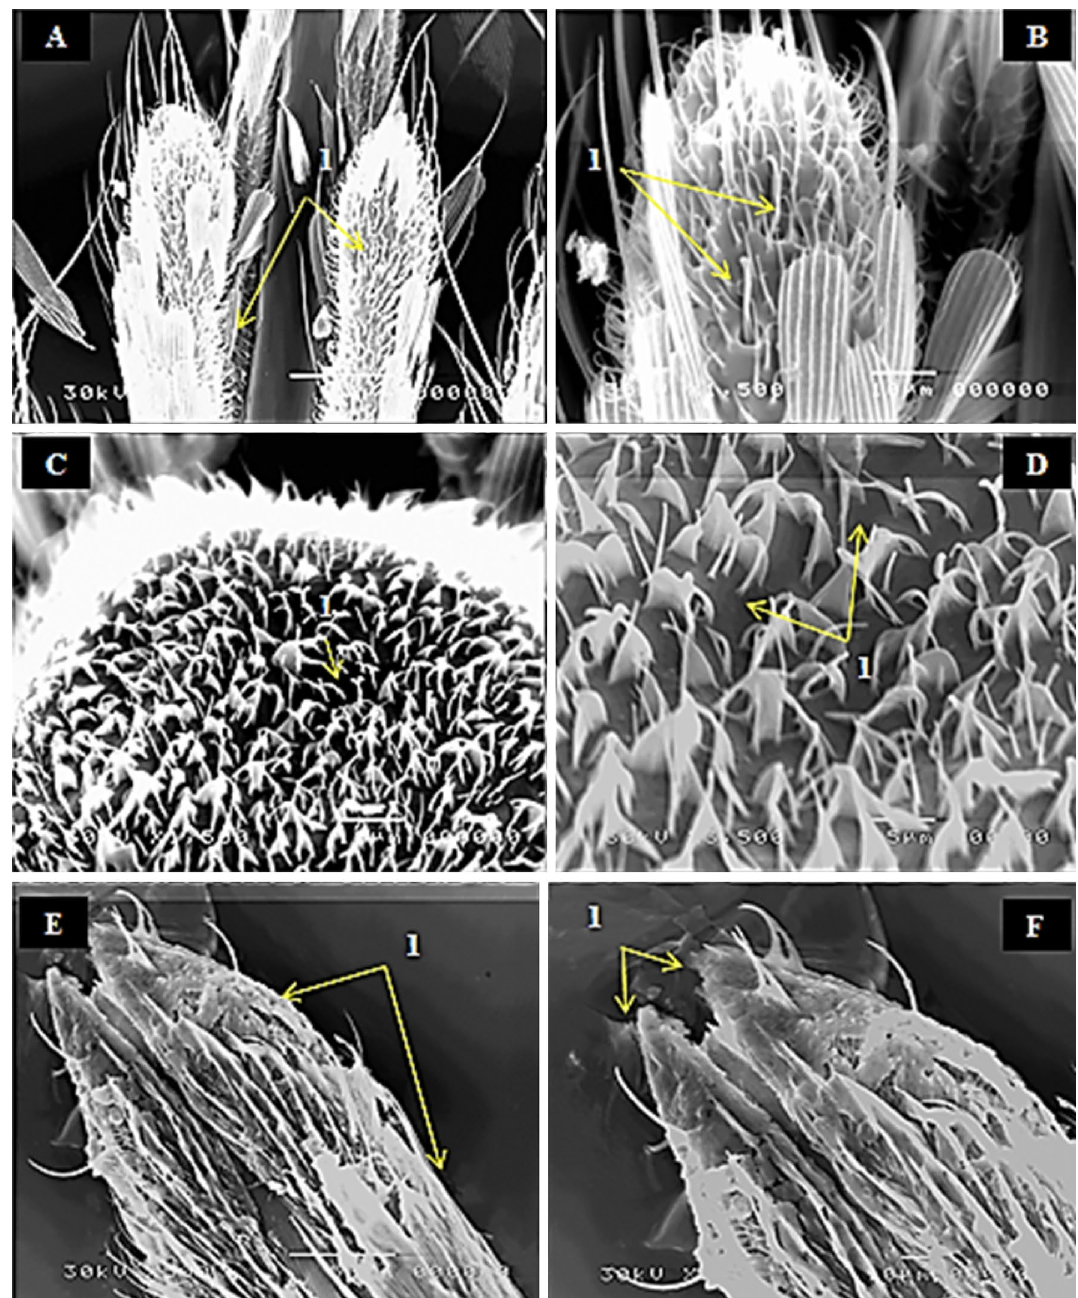
Figure 7. SEM photography of irradiated female mosquito, Culex pipiens as pupae with 80 Gy ( A-1 ) showing falling of most sensilla squamiformia (S.Sq), ( B-1 ) dwarfing and shrinkage of capitate peg sensilla (C.Ps) at the distal end of maxillary palp. ( C-1 ) clumping and sticking of sensilla trichodea (S.Tr), ( D-1 ) higher magnification of clypeus shows changes in the normal shape of sensilla trichodea (S.Tr). ( E-1 ) showing destroy of most sensilla, falling of sensilla chateica (S.Ch), disorganization and loss of labial palps shape. ( F-1 ) tear of the labial palps